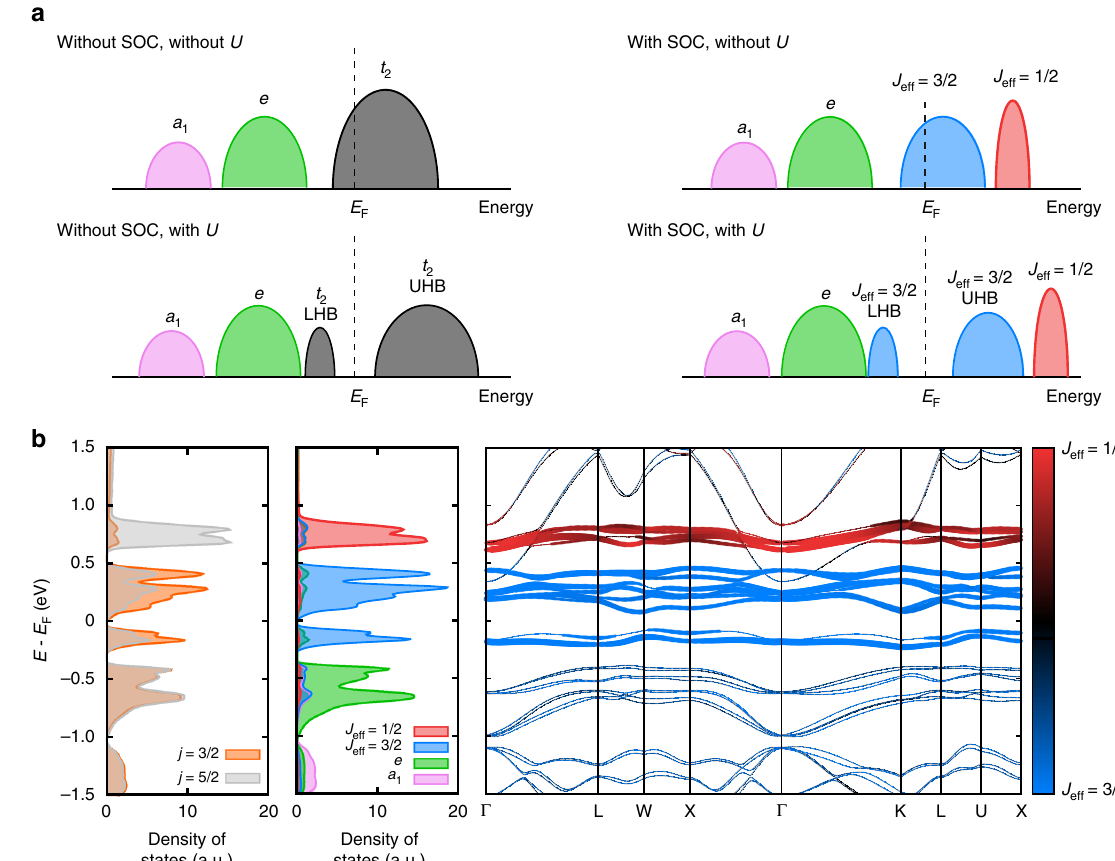
Fig. 4 Schematic representation DOS and the electronic structure near E F . a Schematic representation DOS for cases with and without SOC and electron correlation U . Without SOC and U , t 2 MO band prevails over E F with six-fold degeneracy. SOC (without U ) splits this degenerate band into the four-fold degenerate J eff = 3/2 and two-fold degenerate J eff = 1/2 MO bands. On-site correlation U (without SOC) can split the t 2 MO band into lower Hubbard band (LHB) and upper Hubbard band (UHB). With both SOC and U , the quarter- fi lled J eff = 3/2 MO band splits to LHB and UHB with the higher-lying J eff = 1/2 MO band. Red , blue , green , pink and black colors represent the J eff = 1/2, J eff = 3/2, e , a 1 and t 2 MO characters, respectively. b The calculated band dispersion ( right ) and DOS ( middle ) projected onto the MO states ( a 1 , e , J eff = 3/2 and J eff = 1/2) formed in the Ta 4 cluster, and the calculated DOS projected onto the Ta atomic j = 3/2 and j = 5/2 states ( left ). Red , blue , green and pink colors represent the J eff = 1/2, J eff = 3/2, e and a 1 MO characters, respectively. In the band dispersion the J eff = 1/2 and 3/2 character is also represented by the line thickness. Gray and orange colors indicate the j = 3/2 and j = 5/2 Ta atomic characters, respectively. Notice that the J eff = 1/2 MO band is mostly composed of the atomic j = 5/2